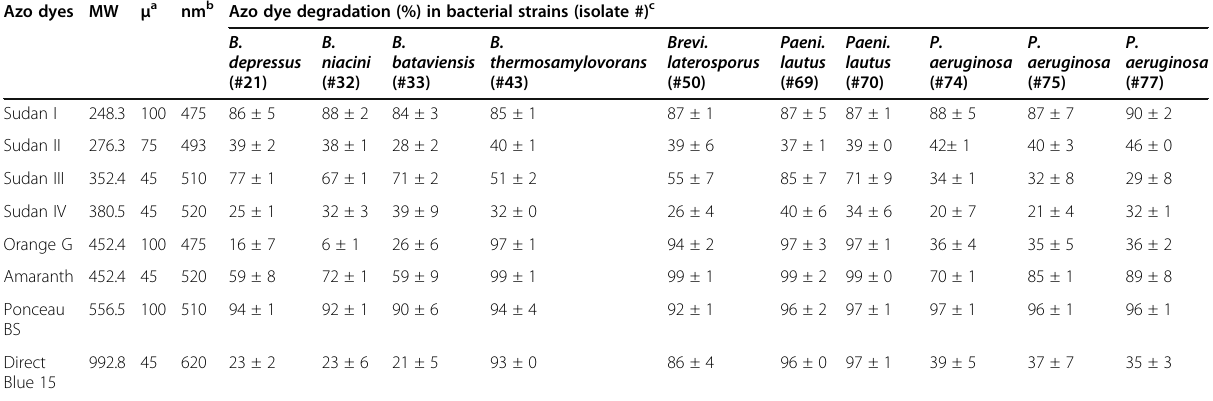
Table 2 Degradation (%) of 8 structurally diverse azo dyes within 48 h by selected bacterial isolates Azo dyes MW μ a nm b Azo dye degradation (%) in bacterial strains (isolate #) c